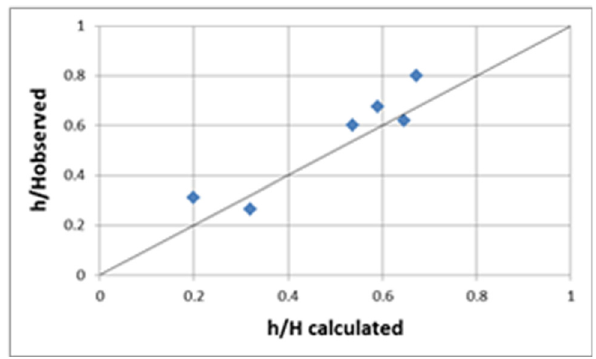
Figure 9: Correlation of the head